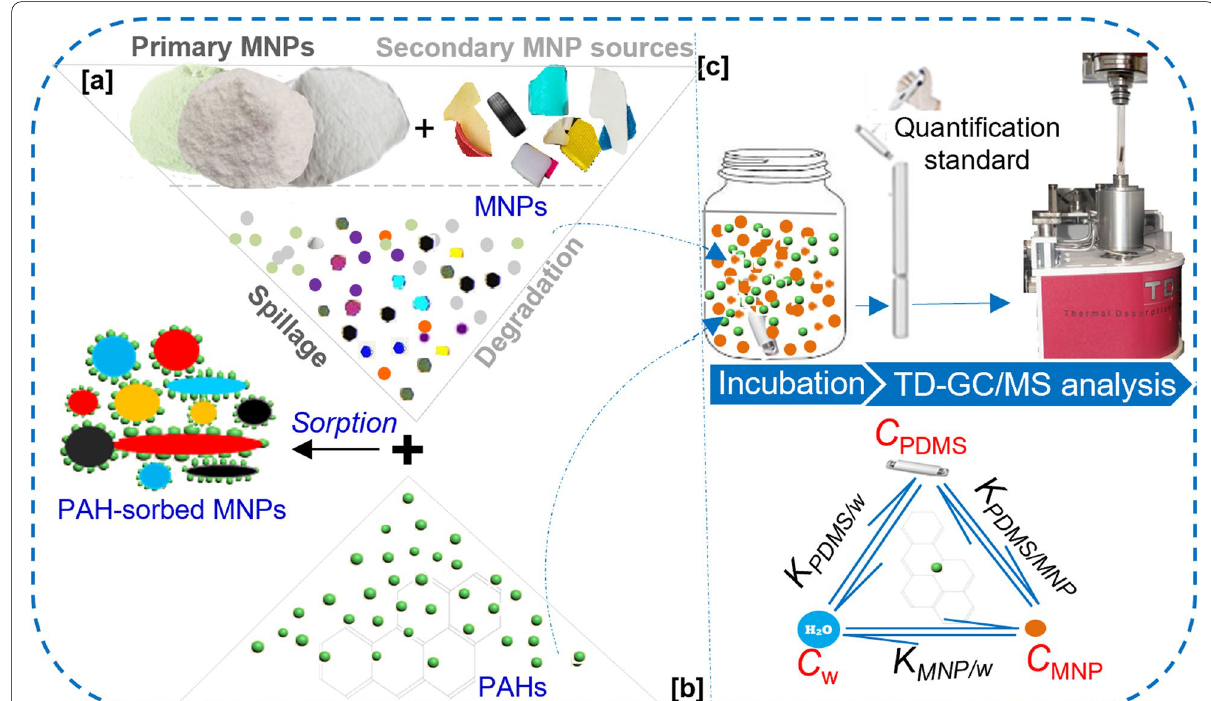
Fig. 1 a Release and exposure sources of micro- and nanoplastic particles (MNPs). b Released MNPs may sorb ubiquitous pollutants such as polycyclic aromatic hydrocarbons (PAHs). c Novel third phase partition (TPP) method reported in this work for evaluating sorption of PAHs to polydisperse real-life-type